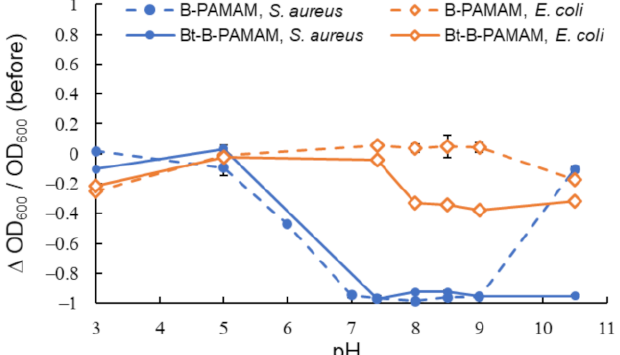
Figure 2. Turbidity changes in bacterial suspensions containing B-PAMAM and Bt-B-PAMAM in PBS buffer ( n = 6). [probe] = 3.3 µ M; [bacteria] = 2.3 × 10 8 CFU · mL − 1 . Bars are expressed as standard deviation (SD) for six separate experiments. The number of betaine modifications was 33 and that of boronic acid modifications was